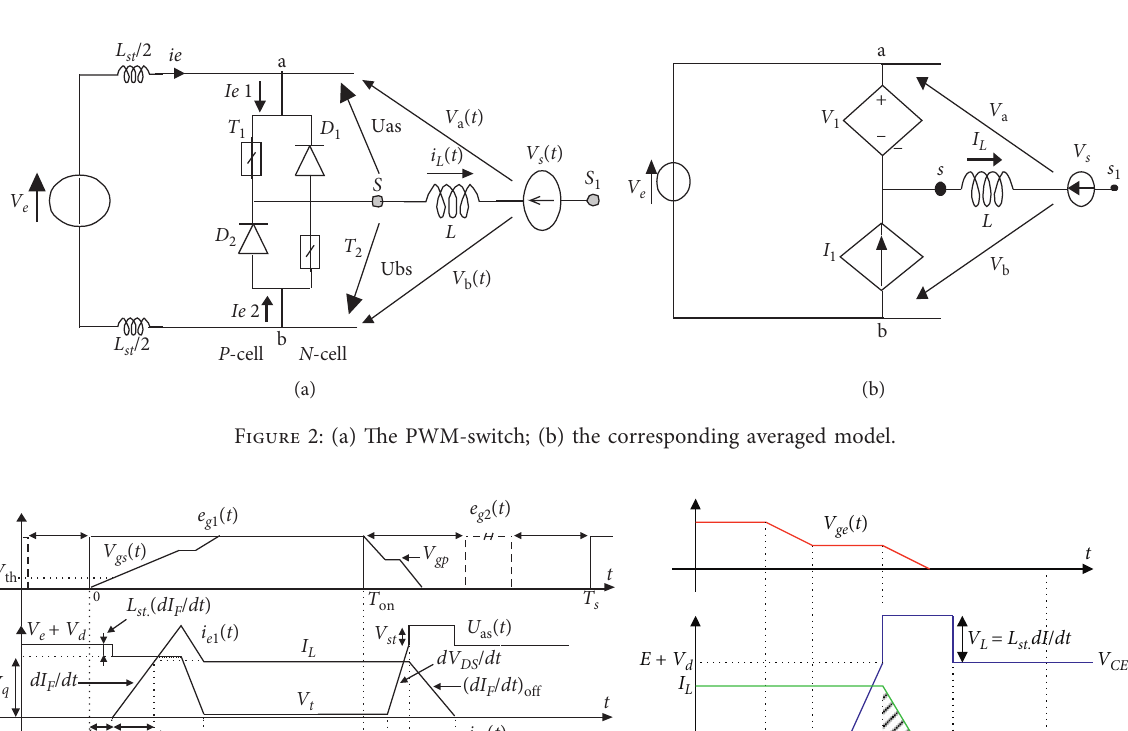
Figure 1: Overview of a grid-connected PV energy conversion